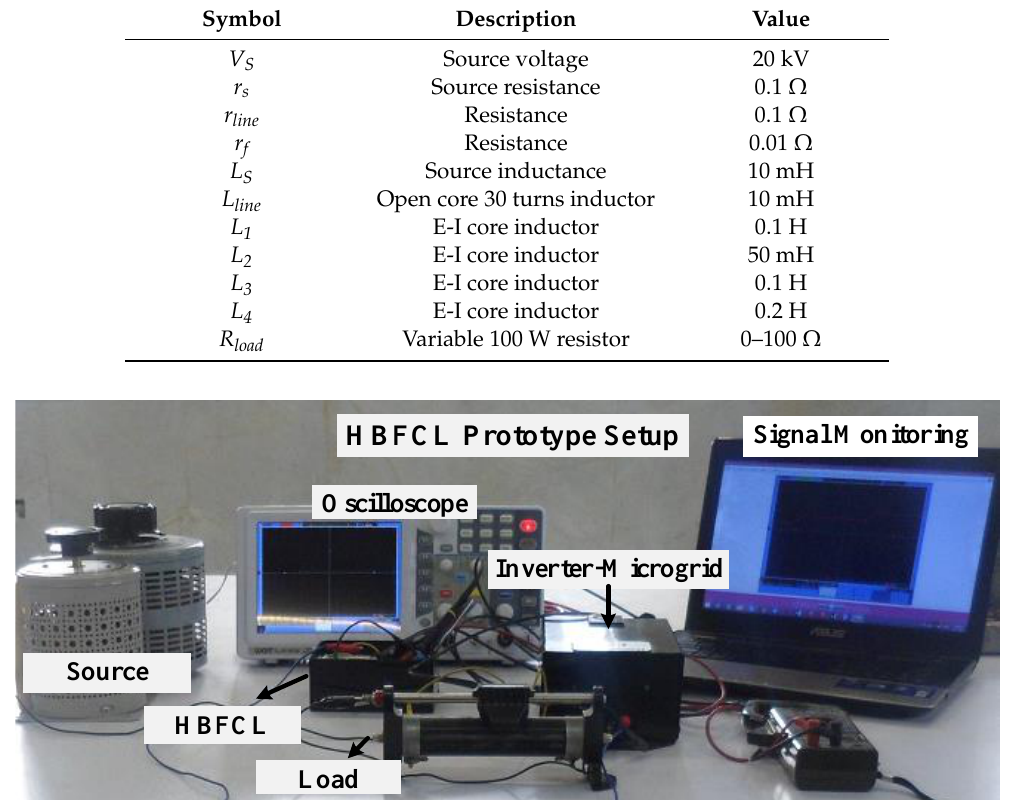
Table 2. The values of prototype parameters.